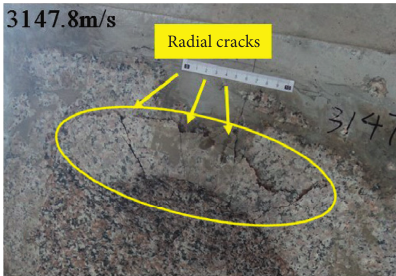
Figure 6: Radial cracks on the free